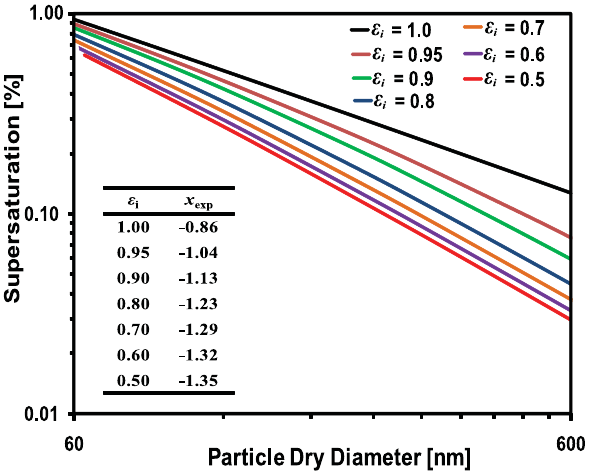
Fig. 8. s c − D dry lines for different values of ε i computed at σ w = 0 . 072Nm − 1 , T = 298 . 15K, A FHH = 2 . 25, B FHH = 1 . 20, κ = 0 . 10. The inset table shows theoretical exponent associated with s c − D dry lines shown in the main figure.